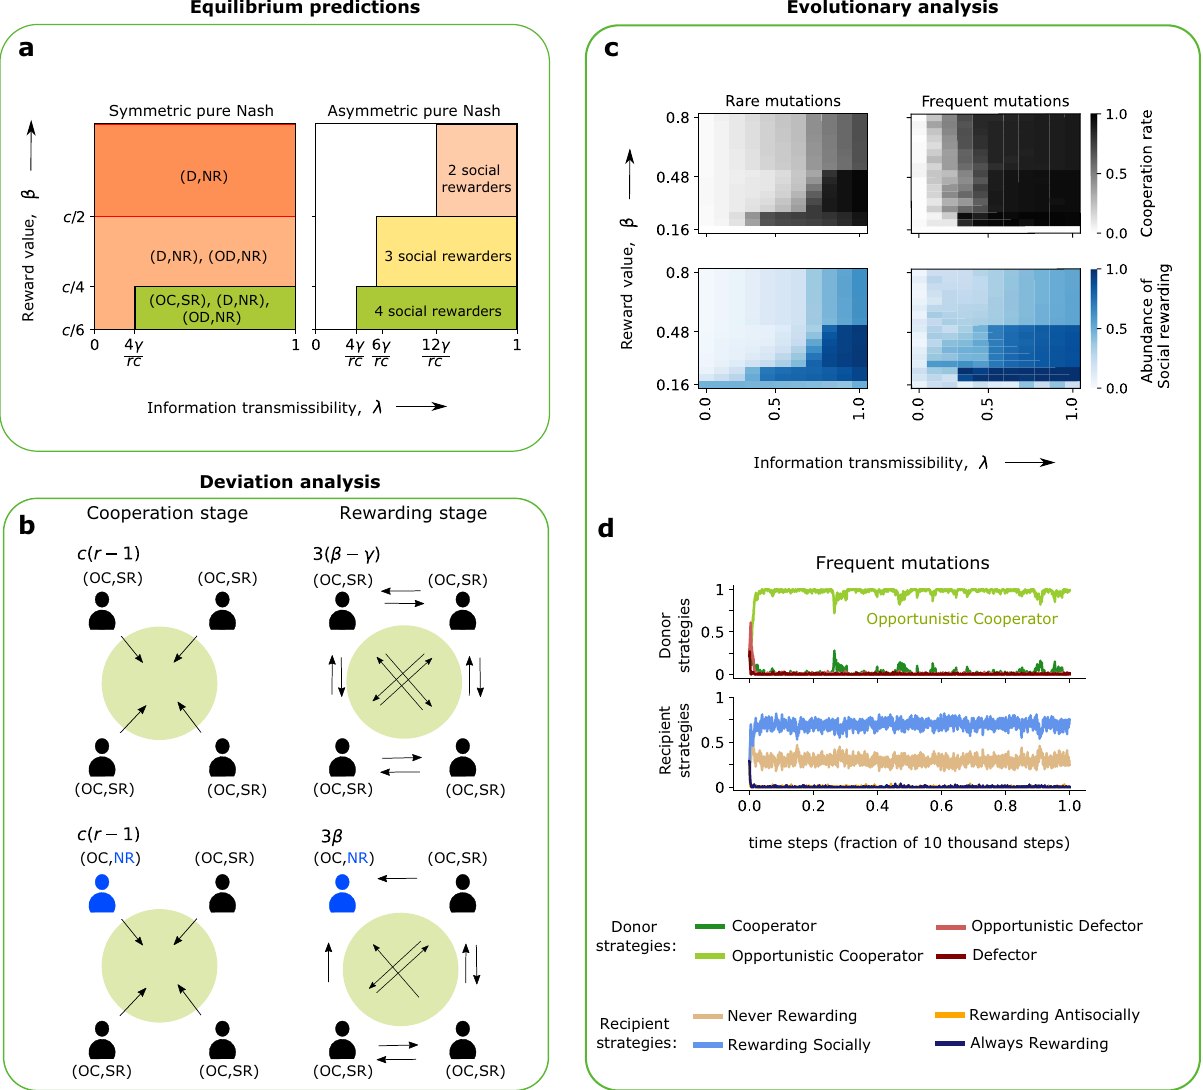
Fig. 4 | Cooperationandrewarding inmultiplayer interactions. Toexplorehow thepreviousresultsonpairwisegamesextendtolargergroups,weconsiderpublic goods games with a subsequent rewarding stage. For the illustration, we consider groups of size N =4. a Again, we fi rst analyze the game's Nash equilibria. We describe both, all pure and symmetric equilibria (left panel), and all equilibria in which social rewarders and non-rewarders may co-exist (right panel, showing how many of the four group members are social rewarders in the respective equili- brium). In general, a high information transmissibility λ makes it more likely that cooperation can be sustained in equilibrium. However, as rewards become increasingly effective (higher β ), individuals may engage in second-order free rid- ing.Suchindividualscontributetothe publicgood, but theydonot reward others. b Here, we illustrate how second-order free riding can emerge. If β is suf fi ciently